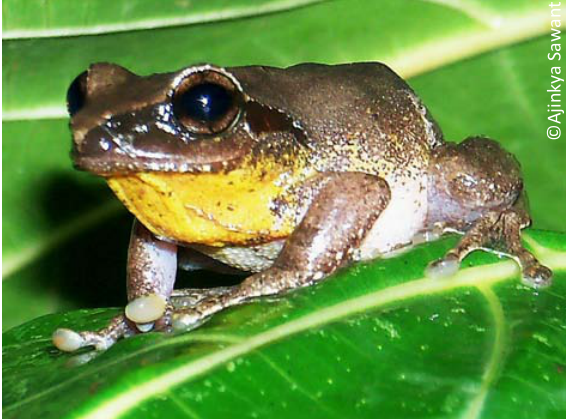
Image 7. Uperodon globulosus